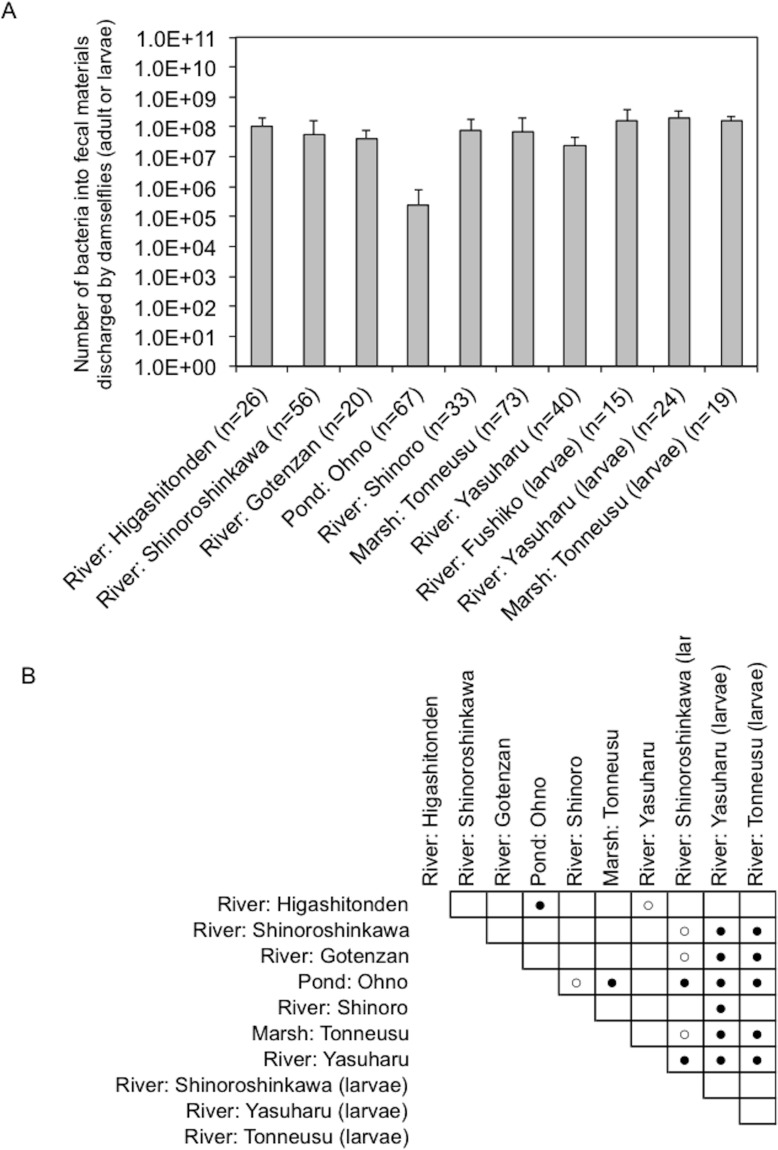
Bacterial load in fecal materials estimated following culture on SCD agar plates without antibiotics.(A) shows total bacterial numbers (CFU) in samples from adult and larval damselflies. (B) shows results of statistical analyses performed to compare results among sampling locations. Comparisons of the total CFU counts among sampling locations were conducted using a Bonferroni/Dunn test. Closed and open circles show statistical significance at P < 0.01 and P < 0.05, respectively.